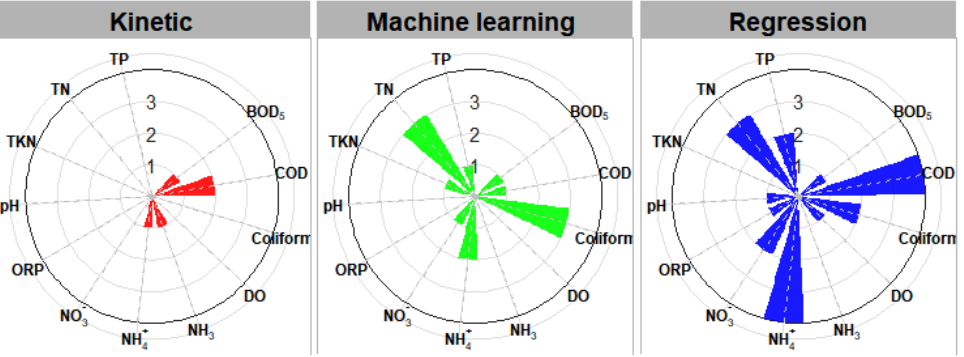
Figure 12. Modeling approaches associated with water quality indicators in the MSL systems with scale inside plot indicates how many times the modeling approach has been utilized.